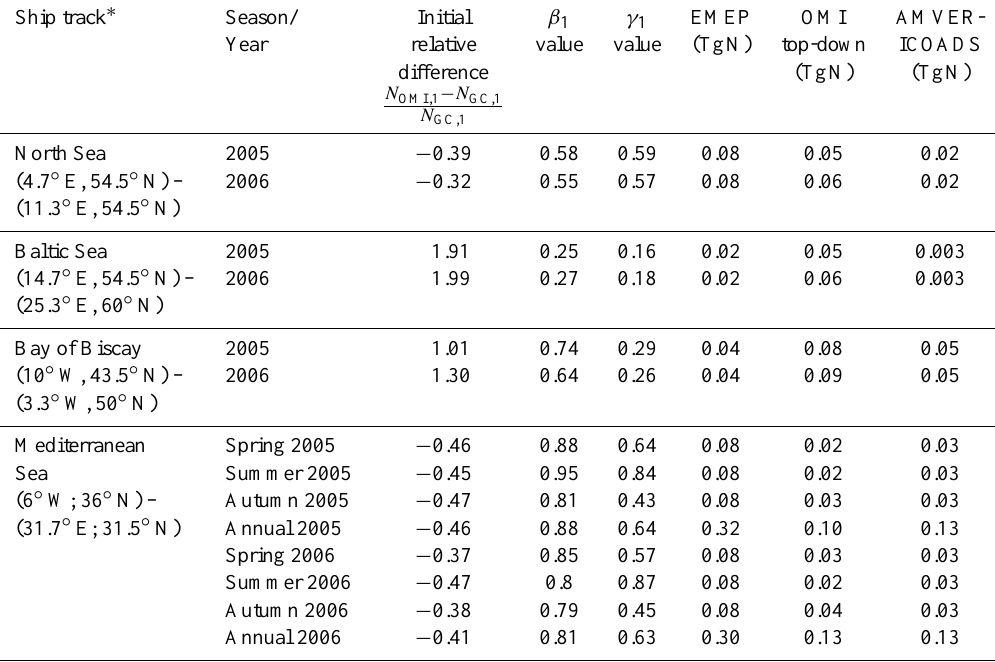
Table 2. Overview of total ship NO x emissions for different ship tracks (as defined in Fig. 9b): in the EMEP and AMVER-ICOADS emission inventories, and our OMI top-down inventory for 2005–2006. For the North Sea, the Baltic Sea and the Bay of Biscay, annual constraints are given. More cloud-free observations are available for the Mediterranean Sea and we provide seasonal constraints for this ship track, although winter constraints could not be determined. Beta and gamma values are calculated as indicated in Sects. 3.2. and 3.3. Note that the combined EMEP-AMVER-ICOADS inventory (Fig. 7d) used in this study has the same emission totals as the EMEP inventory.